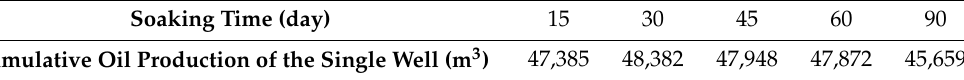
Figure 13. Comparison of oil increment of AIIP in each scheme under different soaking times.